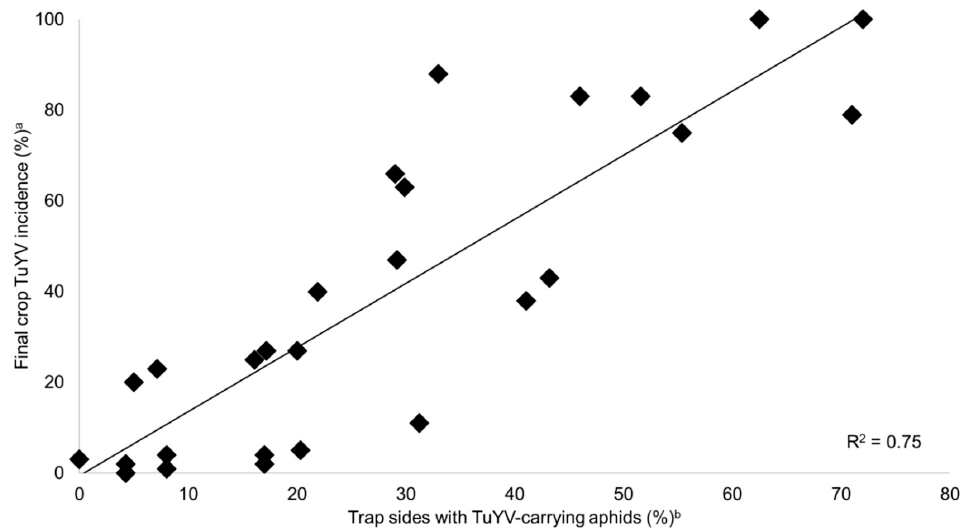
Figure 3. Relationship between final crop Turnip yellows virus (TuYV) incidence and percentage (%) of trap sides with TuYV-carrying aphids deployed in a four to twelve week period prior. a Final TuYV incidence data point used was at end of exponential spread or final sampling. Tip leaf samples from 100 to 200 individual canola plants tested for TuYV by enzyme-linked immunosorbent assay. b Three double-sided yellow sticky traps deployed and collected on edge of canola crop every two weeks during the four to twelve week period prior to final incidence. Aphids caught on each trap side were pooled, homogenized, and the crude extract tested for TuYV by reverse transcription loop-mediated isothermal amplification.